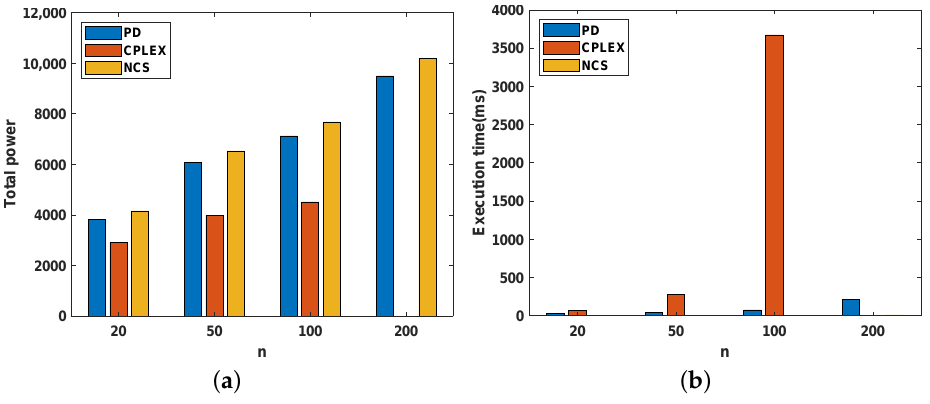
Figure 2. System performance with different numbers of users. ( a ) Total power. ( b ) Execution time